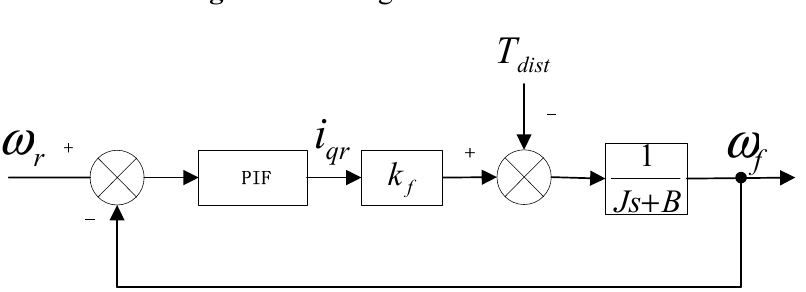
Figure 2. Average model of